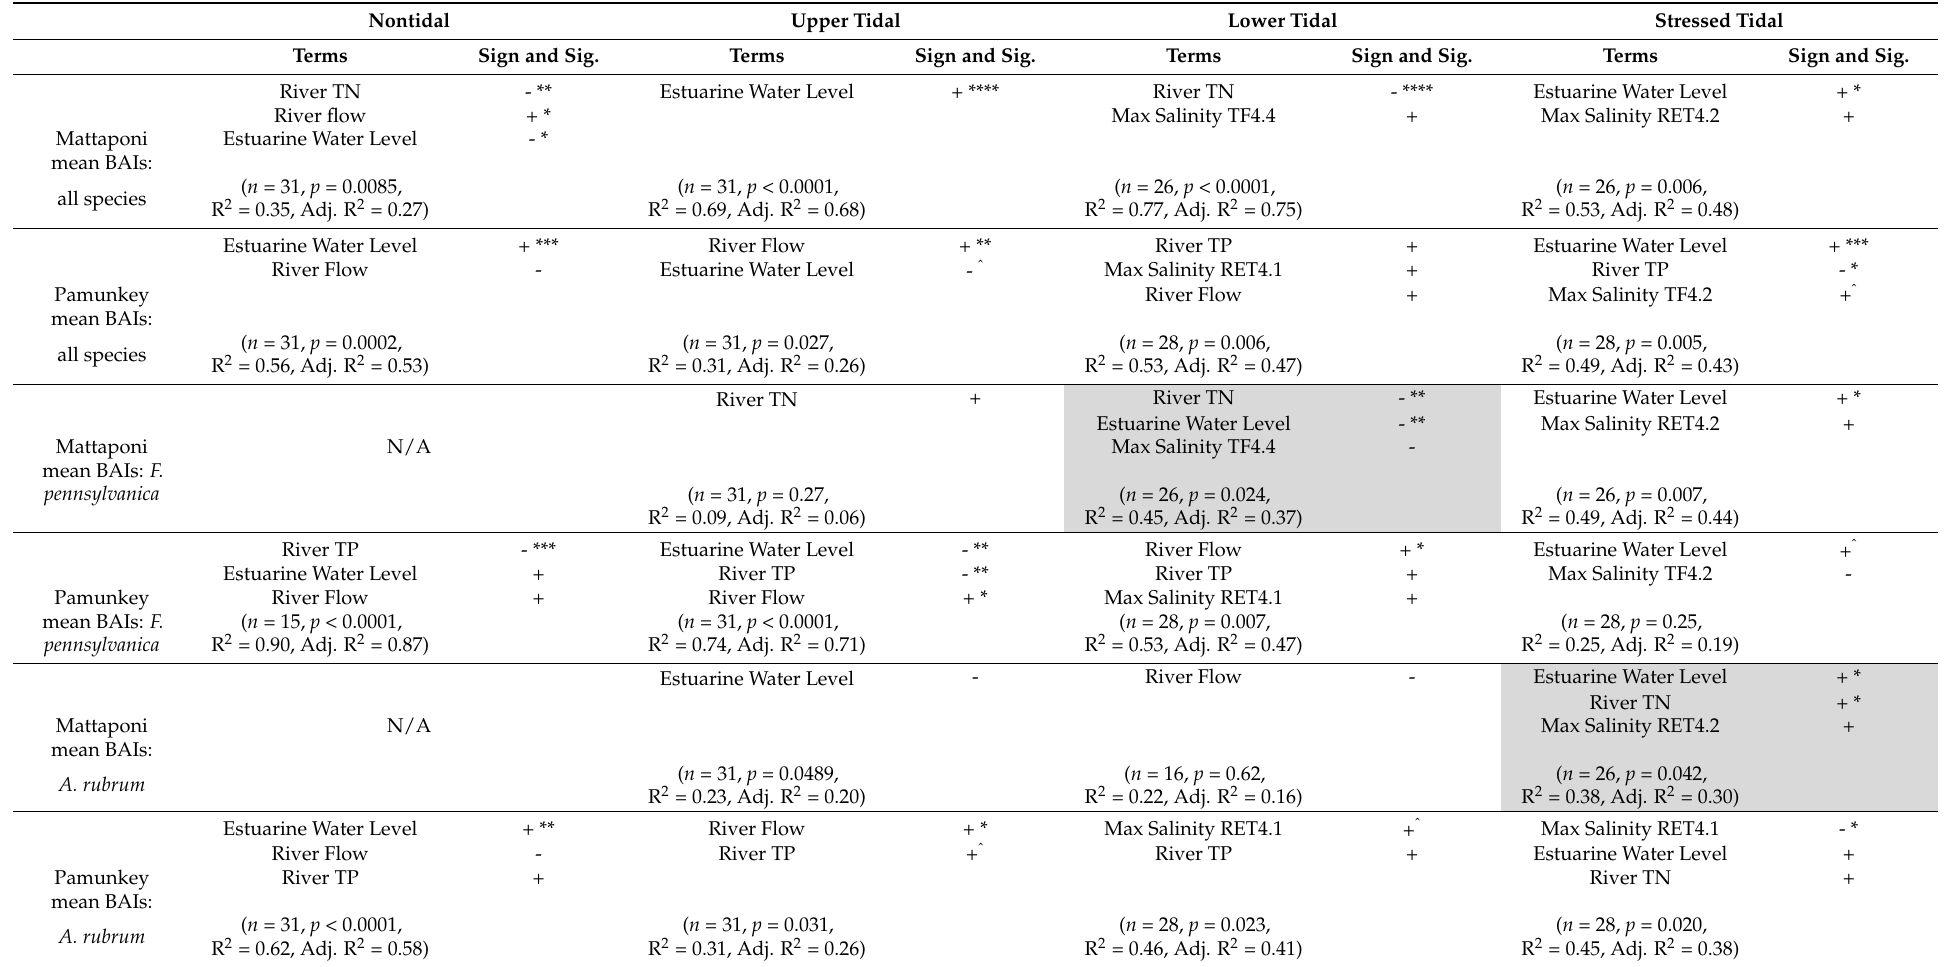
Table 3. Best model results from all-possible regression analyses of the effects of watershed and estuarine variables on the mean basal area increment (BAI) growth of trees at study sites on the Mattaponi and Pamunkey rivers. Significance of individual terms in models: ˆ = p < 0.075; * = p < 0.05; ** = p < 0.01; *** = p < 0.001; **** = p < 0.0001. N/A = no significant model possible. Grey-shaded cells indicate the regression included 1-year lagged (prior year) effects of predictors on